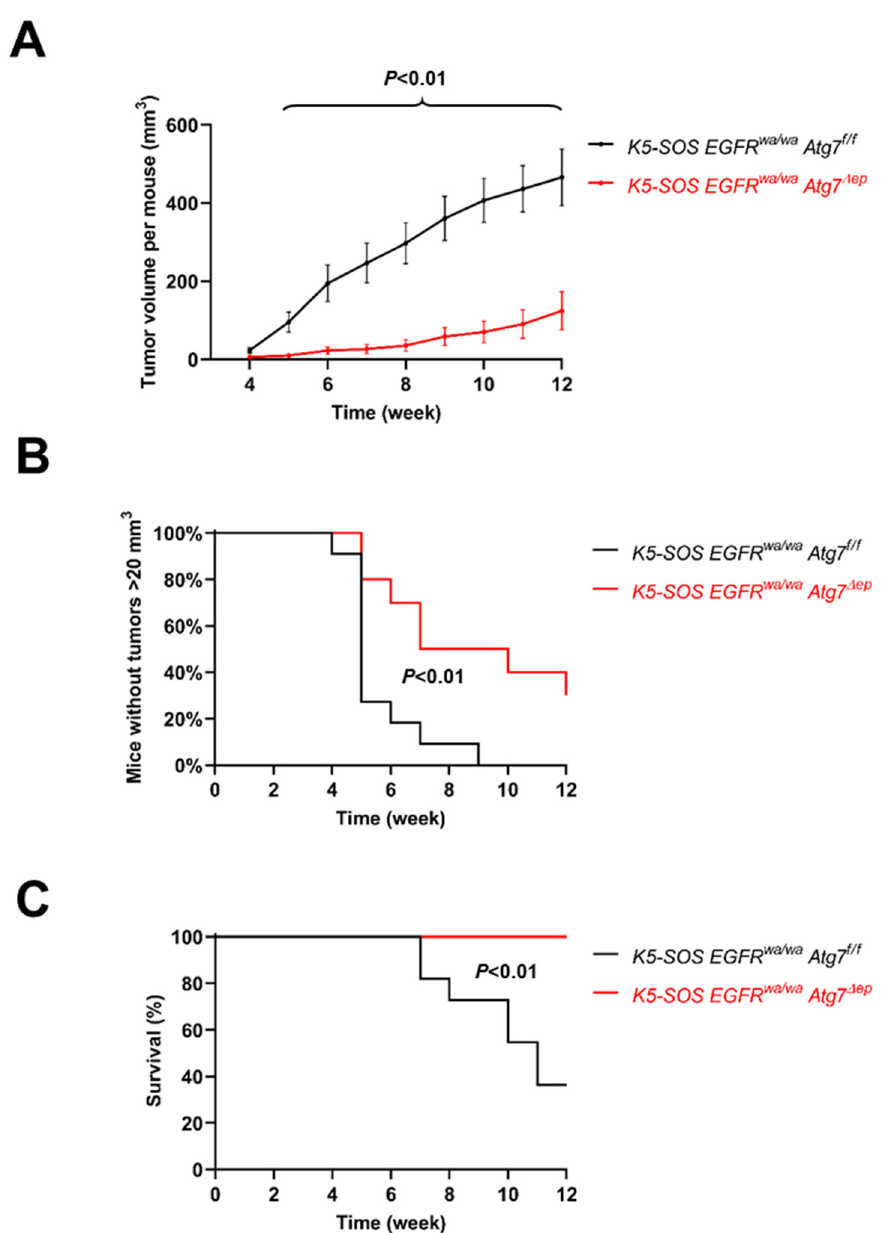
Figure 3. Inactivation of Atg7 impairs K5-SOS -dependent skin tumor formation. ( A ) K5-SOS EGFR wa2/wa2 Atg7 f/f ( n = 11) and K5-SOS EGFR wa2/wa2 Atg7 Δ ep ( n = 10) mice were wounded on both ears in week 0 and monitored over the next 12 weeks. The tumor volume was determined every week. Error bars indicate standard error of the mean (SEM). For mice that had to be killed because the tumor diameter reached 10 mm or more, the final tumor volume before death was kept until week 12. The difference between Atg7 f/f and Atg7 Δ ep was significant with p < 0.05 (unpaired t -test) at week 4 and with p < 0.01 in weeks 2–12. ( B ) The absence of tumors with a volume > 20 mm 3 is plotted over time. The difference between Atg7 f/f and Atg7 Δ ep was significant ( p < 0.01, Log-rank (Mantel–Cox) test and Gehan–Breslow–Wilcoxon test). ( C ) Survival of mice. Mice were killed when the diameter of a tumor reached 10 mm. The difference between Atg7 f/f and Atg7 Δ ep was significant ( p < 0.01, Log-rank (Mantel–Cox) test and Gehan–Breslow–Wilcoxon test).